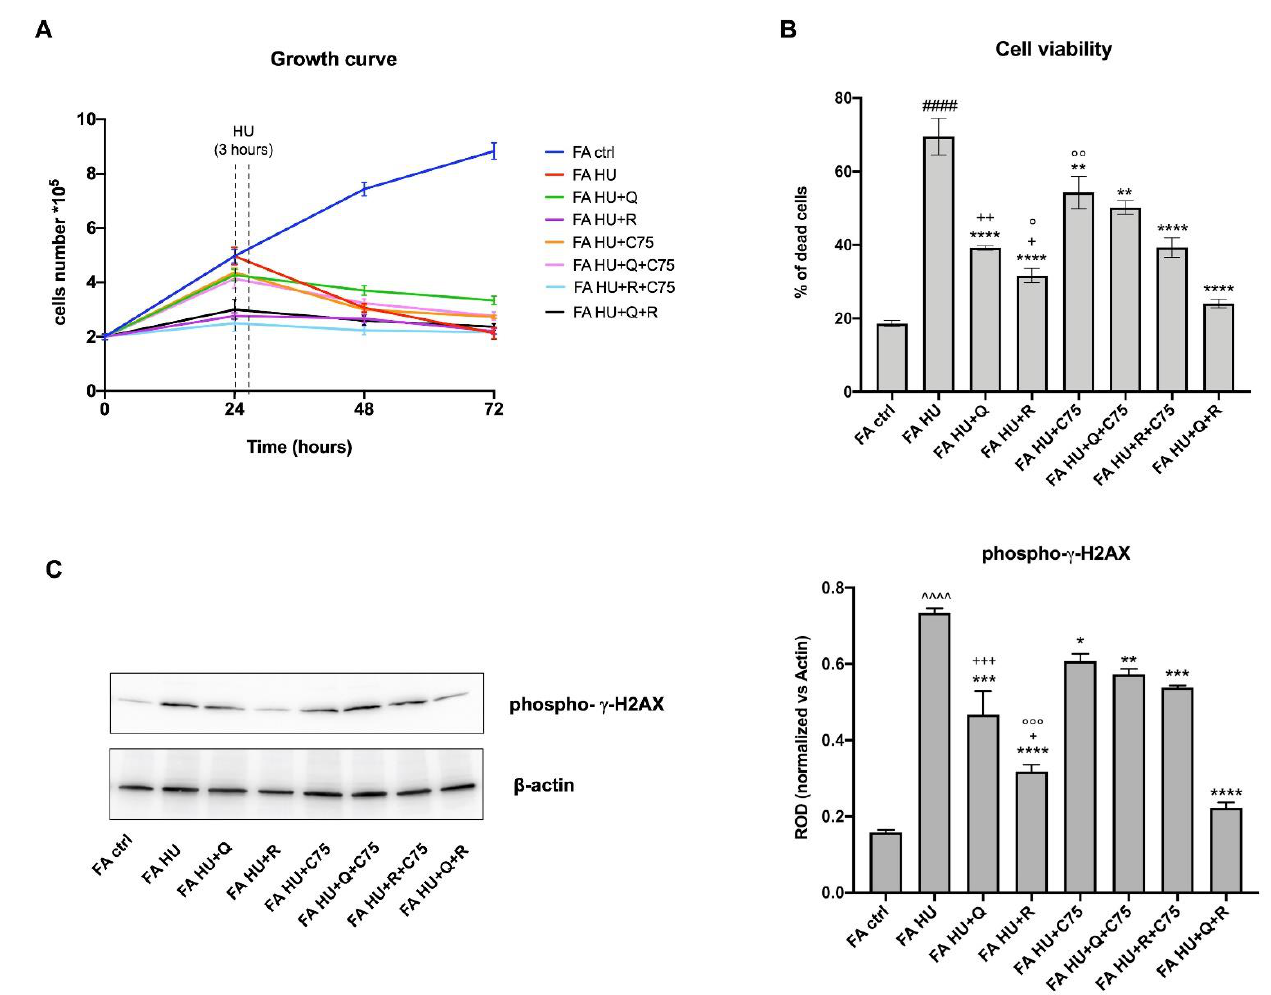
Figure 7. Effect of quercetin, rapamycin, C75, and their combination on damages and DNA double-strand breaks induced by hydroxyurea. Data reported in Panels B and C represent experiments conducted after 48 h of drug treatments. ( A ) Cell growth curves ( B ) Percentage of dead cells. ( C ) Left: WB signals against phospho- γ -H2AX and β actin, used as a housekeeping protein. Right: densitometric analysis of WB signal. (HU = hydroxyurea; Q = quercetin alone; R = rapamycin alone; C75 = C75 alone; Q + C75 = quercetin/C75 combination; R + C75 = rapamycin/C75 combination; Q + R = quercetin/rapamycin combination). Each graph represents four independent experiments and data are expressed as mean ± S.D. For FA and FA-corr cells, data are representative of four different Fanc-A lymphoblast cell lines. Statistical analysis was performed via one-way ANOVA followed by Tukey multiple comparison test. #### or ˆˆˆˆ indicates a p < 0.0001 between untreated FA (FA ctrl) cells and FA cells treated with HU (FA HU). *, **, ***, or **** indicate a p < 0.05, 0.01, 0.001, or 0.0001 between untreated and treated FA HU cells. +, ++, or +++ indicate a p < 0.05, 0.01, or 0.001, respectively, between treatment with quercetin or rapamycin alone and quercetin/rapamycin combination; ◦ , ◦◦ , or ◦◦◦ indicate a p < 0.05, 0.01, 0.001 between treatment with rapamycin or C75 alone and rapamycin/C75